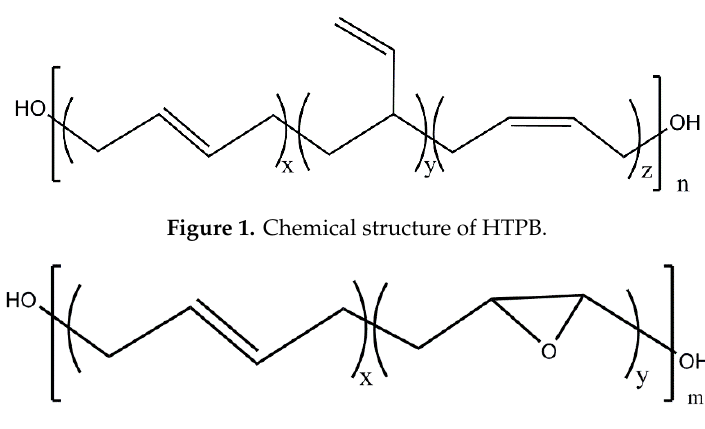
Figure 2. Chemical structure of EHTPB.